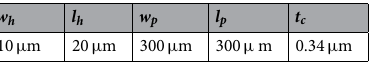
Table 1. Design parameters of the